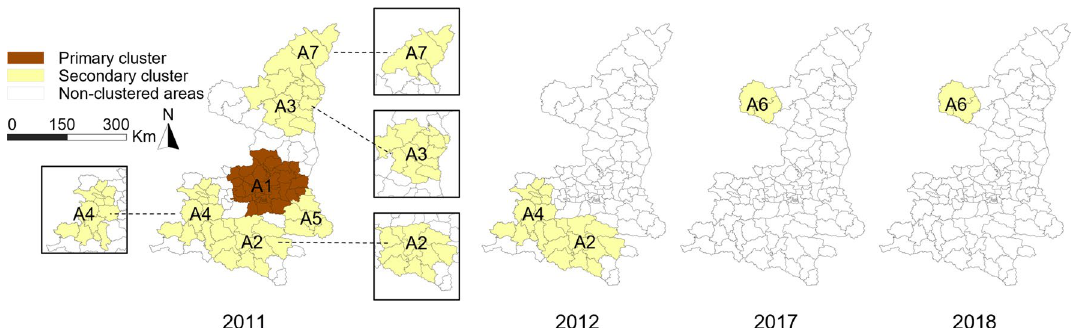
Figure 7. Spatiotemporal clusters of